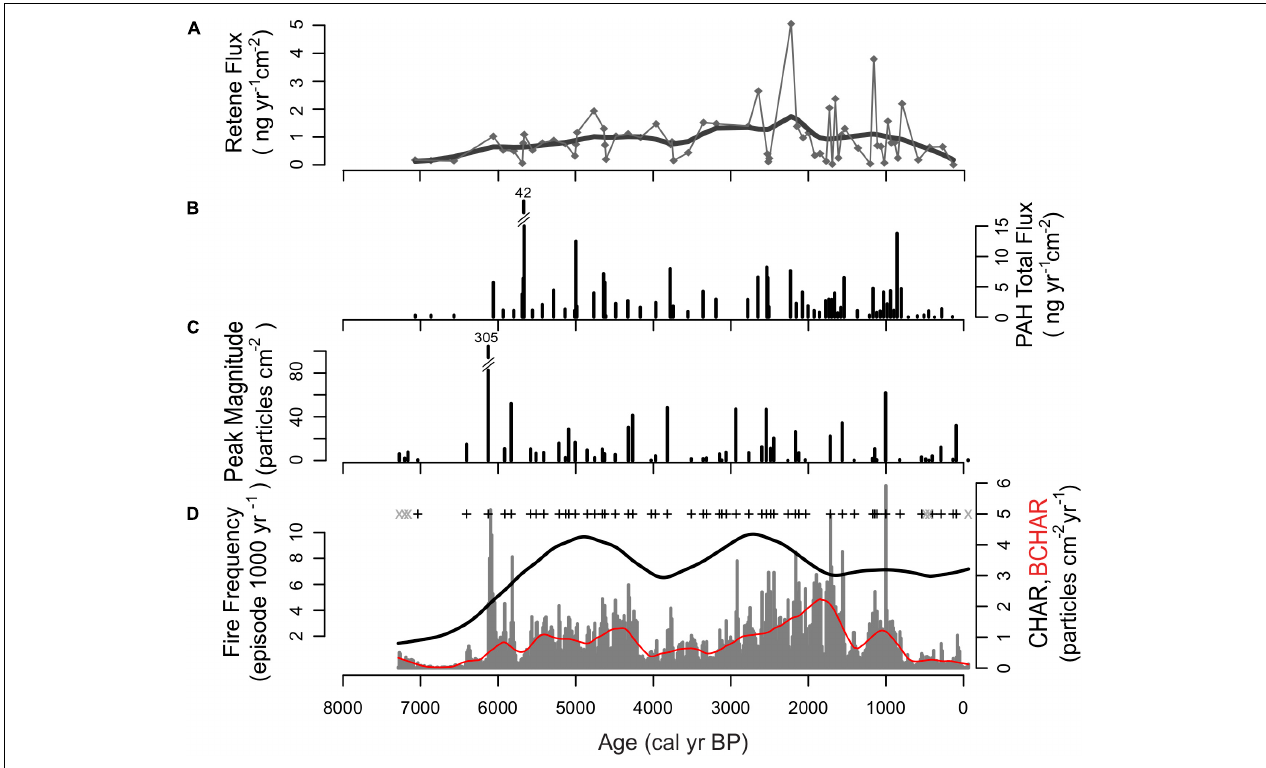
FIGURE 5 | Reconstruction of fire activity from multiple proxies from Black Lake sediments. (A) PAH flux. (B) Retene flux. (C) Charcoal peak magnitude. (D) Charcoal influx and fire frequency data; gray “x” represent insignificant fire peaks; black “+” represent significant fire peaks; red line represents background charcoal component